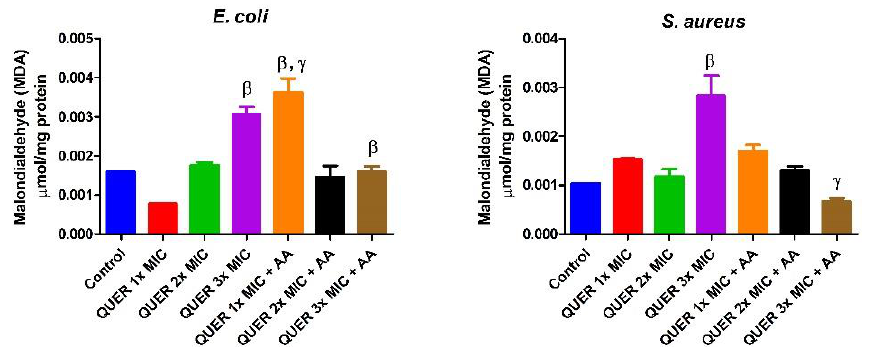
Figure 4. Malondialdehyde concentration in bacterial isolates following exposure to quercetin (QUER) alone or when combined with ascorbic acid (AA) . Results are presented as an average of duplicate biological experiments (n = 2) with the corresponding standard error of the mean (SEM). Compared with control or QUER 3x MIC, β at p < 0.01 is significant and γ at p < 0.0001 compared with QUER 1x MIC or QUER 3x MIC.